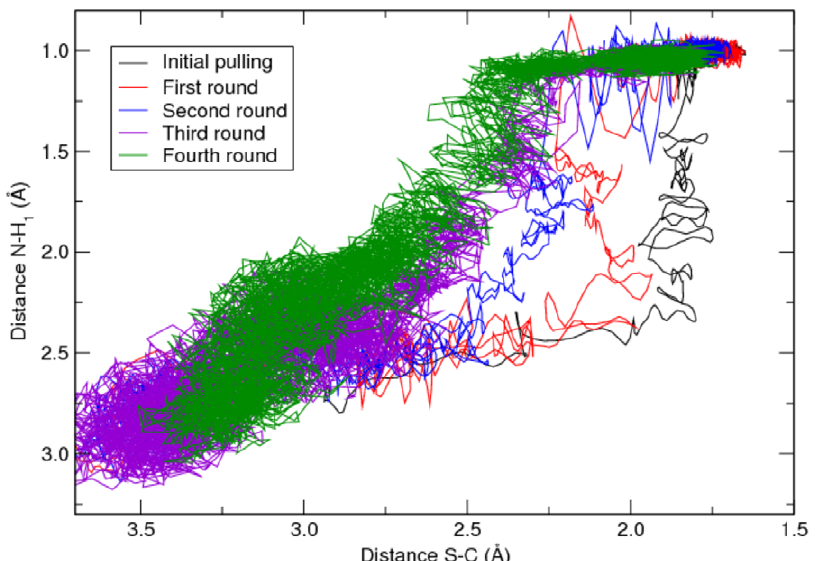
Figure 5. Evolution of the reaction path from steered-MD/PCVs simulations. The initial pulling showing the nucleophilic attack (described by the S, C distance), occurring before the proton transfer reaction (N, H 1 distance), is displayed as a black line. The first steered-MD round is featured by a similar reaction path. Conversely, the last three steered-MD runs show a different mechanism, where protonation of the nitrogen (N) occurs at the same time (run three) or even before the nucleophilic attack. The steered-MD rounds third and fourth displayed a very similar distributions of the S-C and N-H 1 distances, indicating the reaction path is converged in terms of explored configurations of the system.